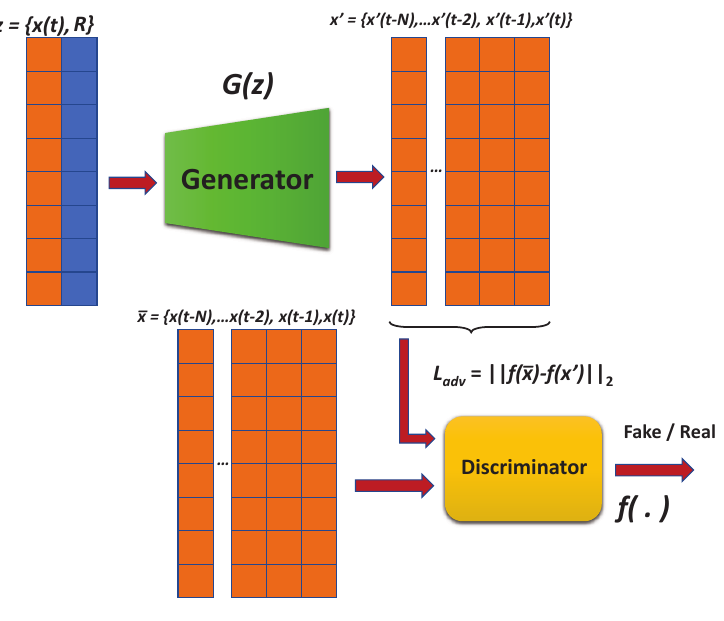
Figure 4. ARIES GAN